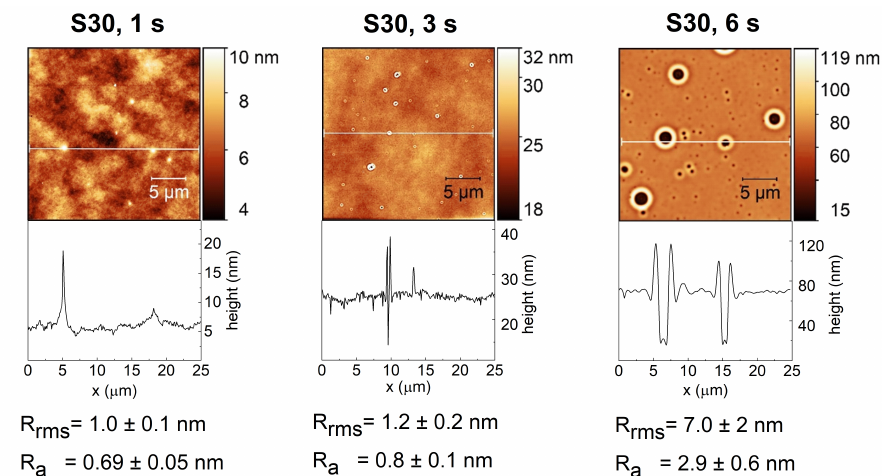
Figure 7. AFM images of pp films after 24 h immersion and their corresponding height profile and roughness. The films were deposited with MC25 at pump speed S30 with different misting times, and plasma-polymerized for 16